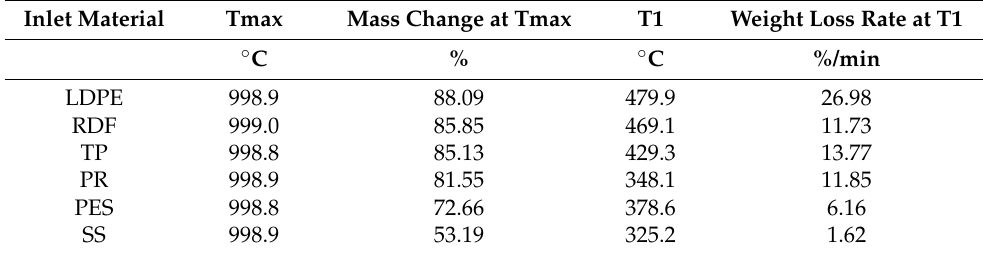
Table 1. Results of TGA/DTG for the input waste materials.